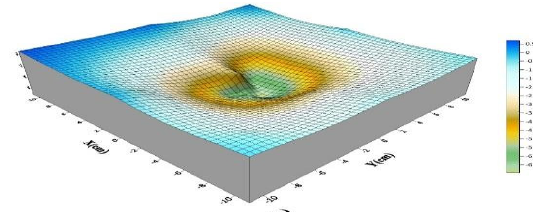
Fig. 7(h): The Scour and Deposition Pattern around Pier (P 1 ) at angle 12 0 and flowrate 14 L/Sec.